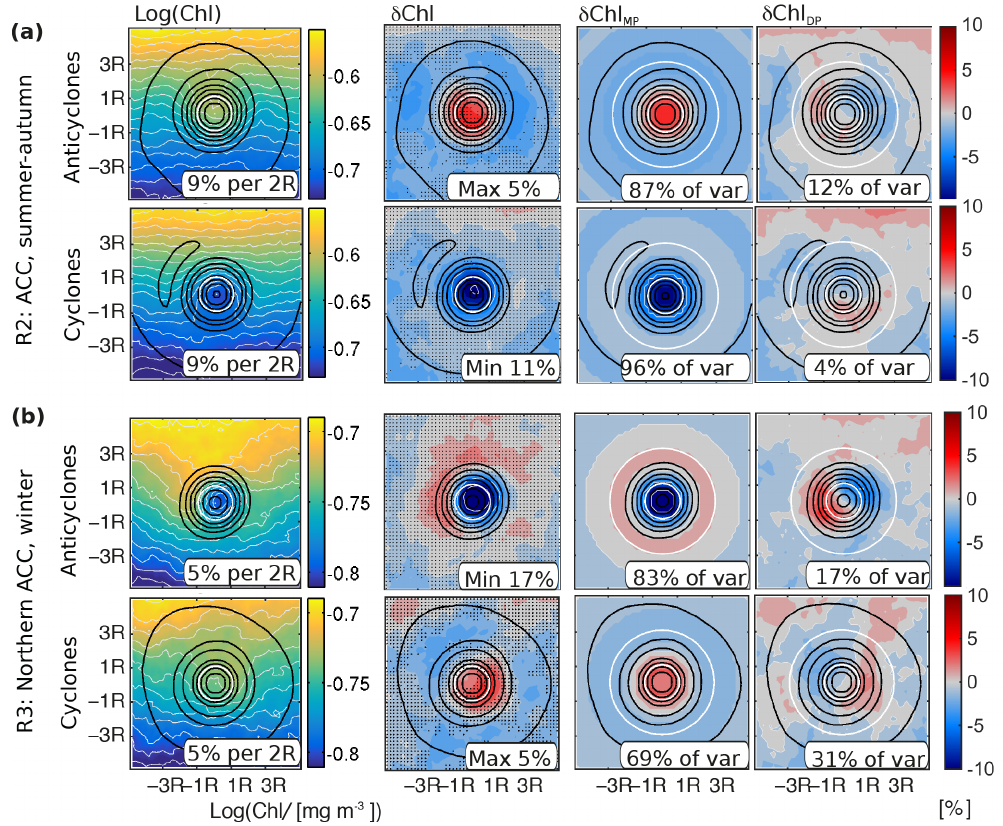
Figure 6. Attribution of stirring/trapping components; same as Fig. 5 but for (a) the region R2 (SSH − 60 to − 40cm, January to May) and (b) for region R3 (SSH − 50 to − 15cm, July to September). The regions are indicated with white boxes in Figs. 4b, c and